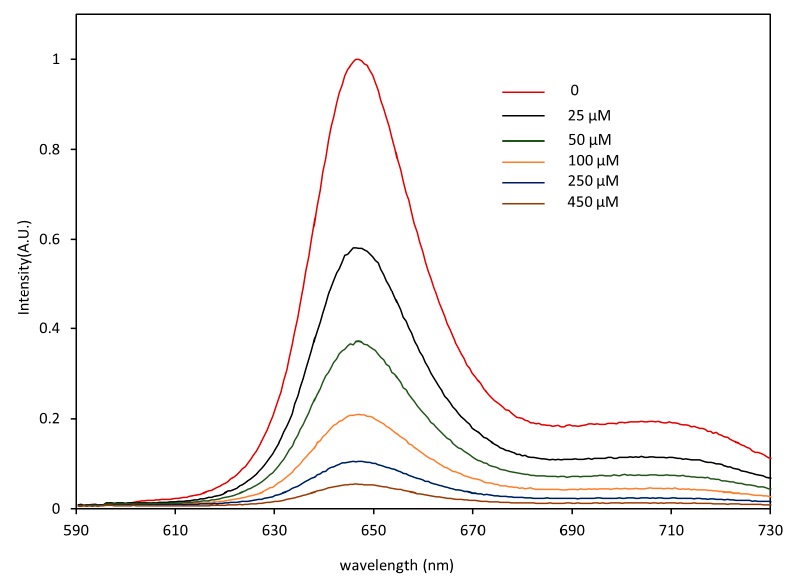
Figure 3. Emission spectra of the PtTFPP-based sensing film with patterned microstructures in waters with different DO concentrations.